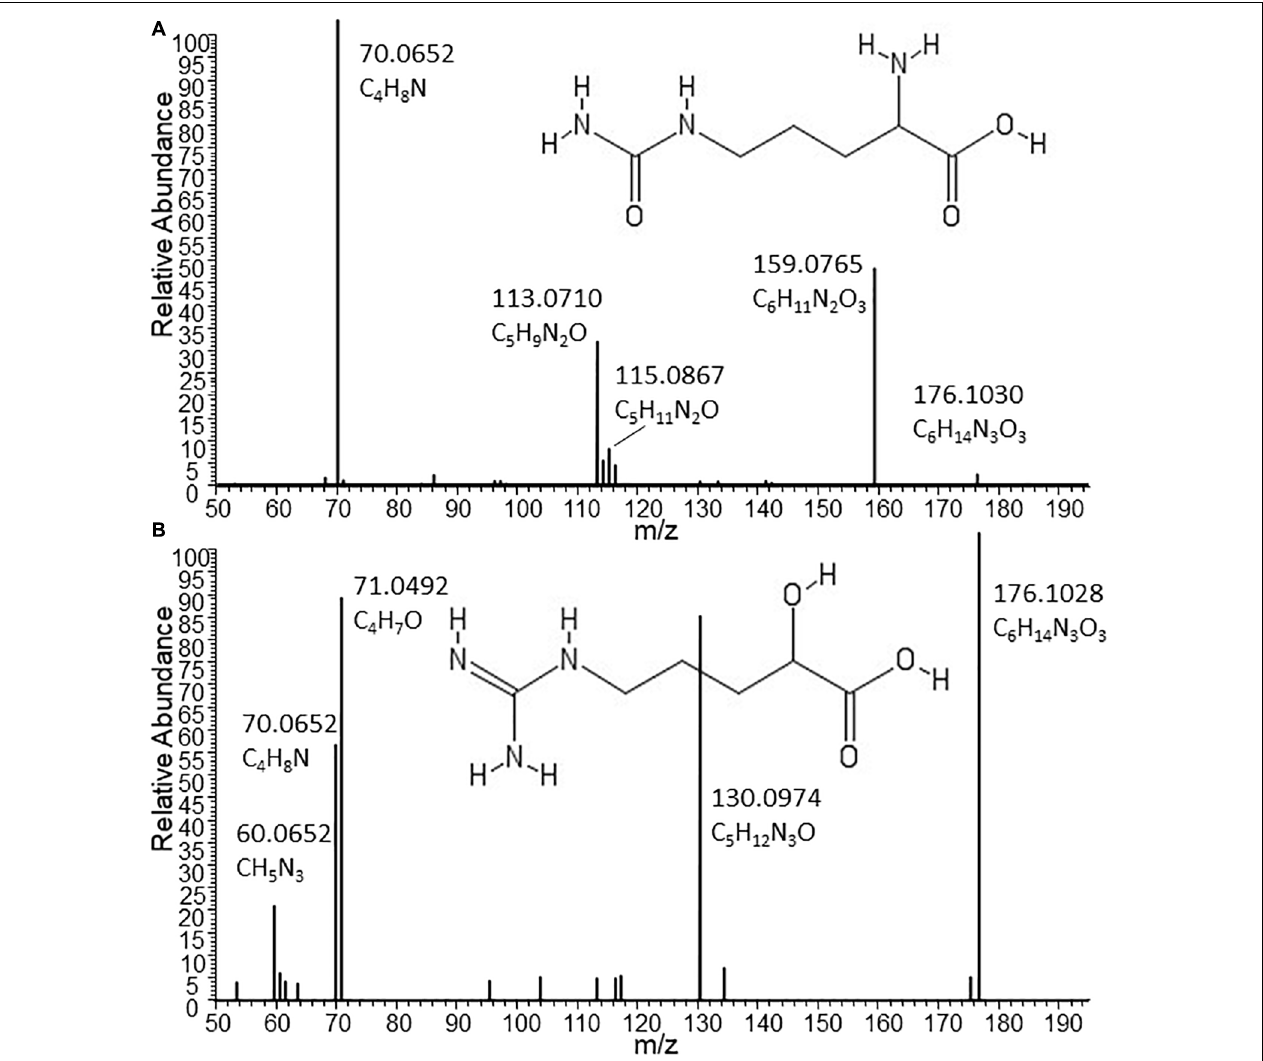
FIGURE 3 | Structures and MS/MS spectra from Citrulline (A) and Arginic acid (B) as found in supernatants of Nissle and CFT073, respectively. The two isomers nearly co-elute under the chromatographic conditions used for this study. Only by MS/MS experiments it could be established that the C 6 H 13 N 3 O 3 metabolite released by the phylogenetically closely related strains CFT073 (as well as NCTC12241/ATCC25922) can be annotated as Arginic acid. Spectrum (A) from Nissle could be matched to reference MS/MS spectra of Citrulline. Absent from (A) , the most intense fragment in spectrum B obtained from CFT073 is C 4 H 7 O, which indicates the likely presence of an C4-alkyl chain with a hydroxyl group (as present in Arginic acid); moreover, the CH 5 N 3 fragment corresponding to the guanine group of Arginic acid is also present in B and absent from A